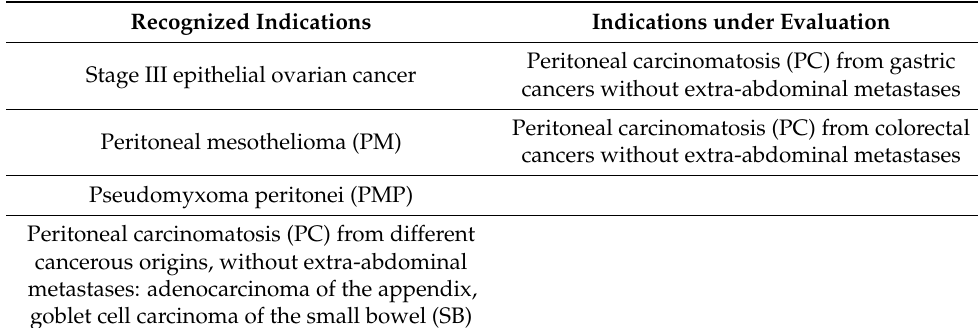
Table 2. Summary table of curative indications of